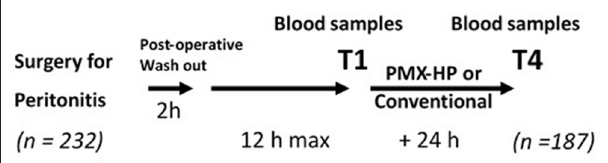
FIGURE 1 | Protocol of the study PMX-HP (Polymyxin-B hemoperfusion). T1, baseline first post-operative measurement; T4, last measurement after PMX-HP or